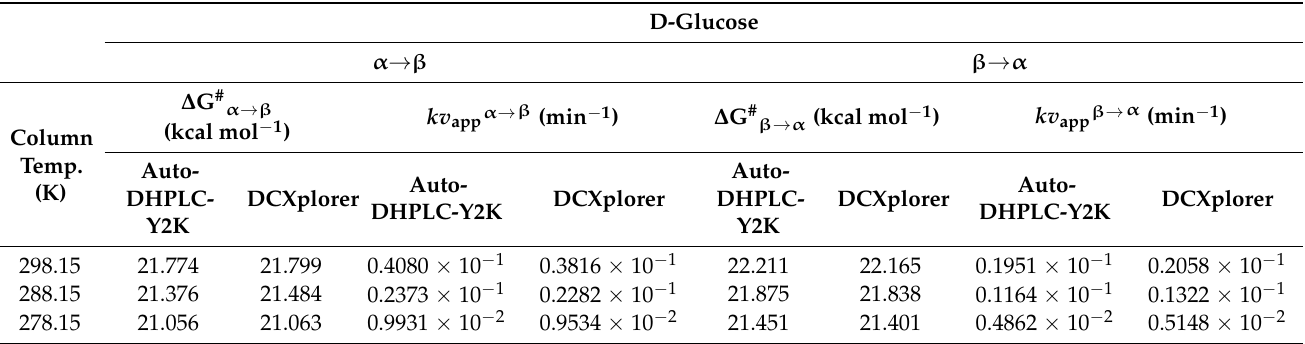
Table 2. Values of ∆ G # and kv app for the processes that lead from the α to the β anomer of D-Glucose, and vice-versa, obtained by simulating experimental dynamic chromatograms with the Auto-DHPLC-Y2K and DCXplorer programs.